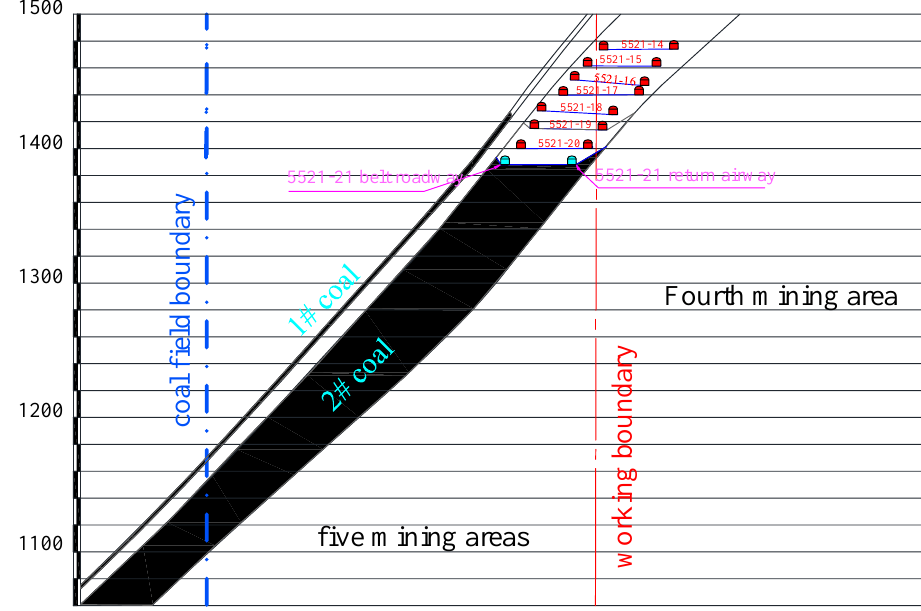
Figure 1. Roadway layout section of 5521-21 working face. Table 1. Roof and floor of the coal seam.